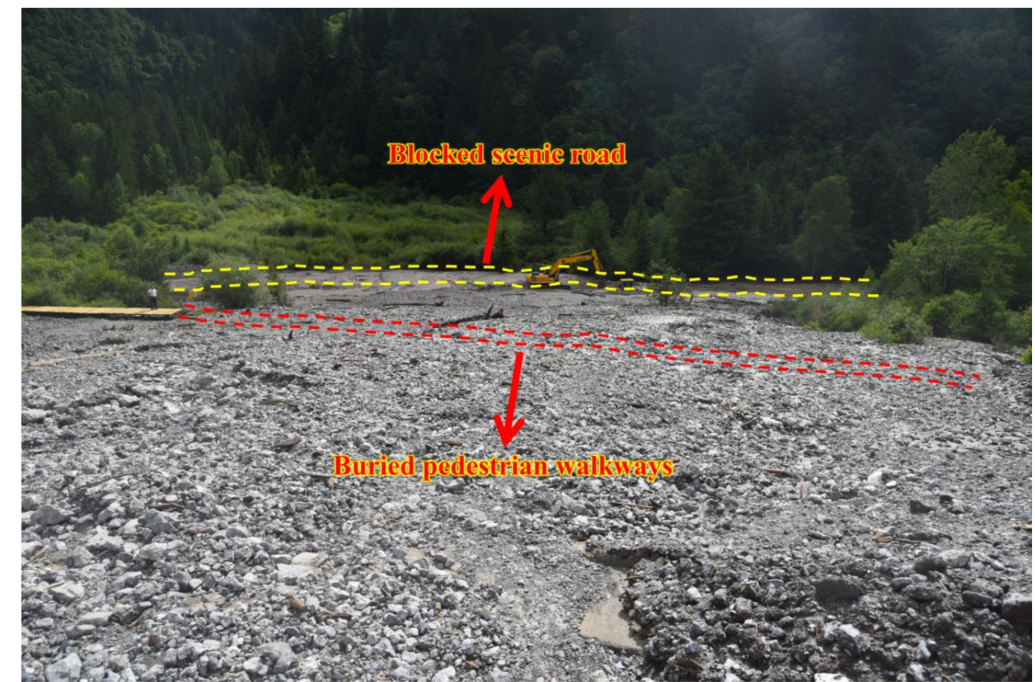
Figure 7. The debris flow that occurred on 21 June 2019 buried pedestrian walkways and blocked the scenic road (taken on 22 June